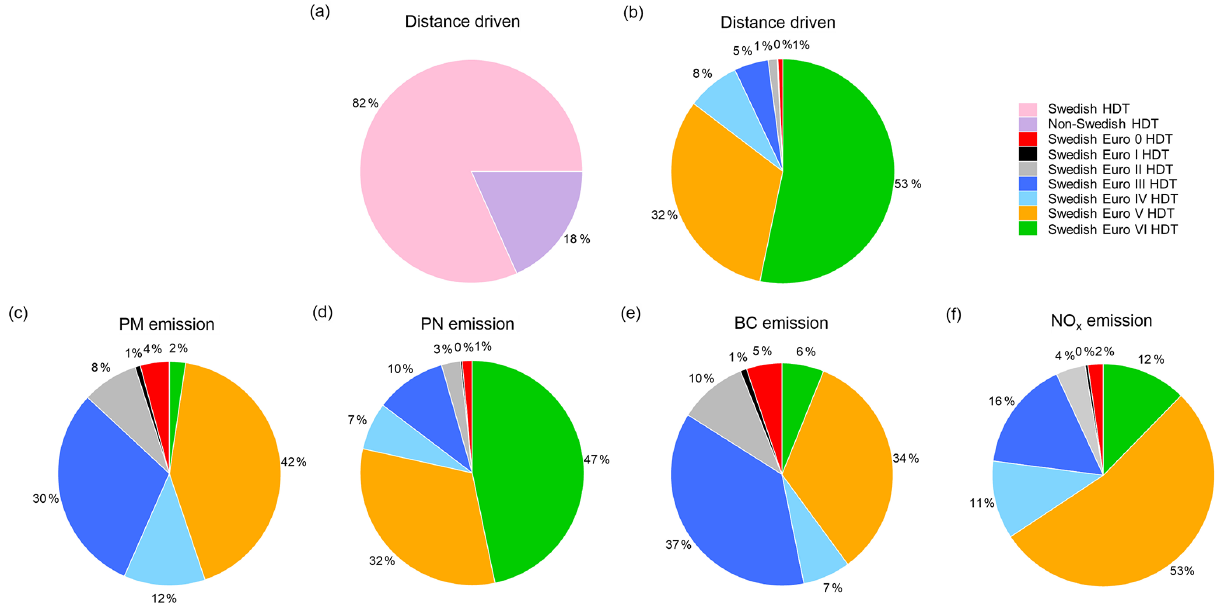
Figure 7. Relative contributions of kilometres driven by (a) Swedish and non-Swedish HDTs and (b) Swedish Euro 0, Euro I, Euro II, Euro III, Euro IV, Euro V, and Euro VI HDTs on Swedish roads during 2018. Approximation of contributions of pollutants emitted from Swedish HDTs in each Euro class to the total (c) PM, (d) PN, (e) BC, and (f) NO x